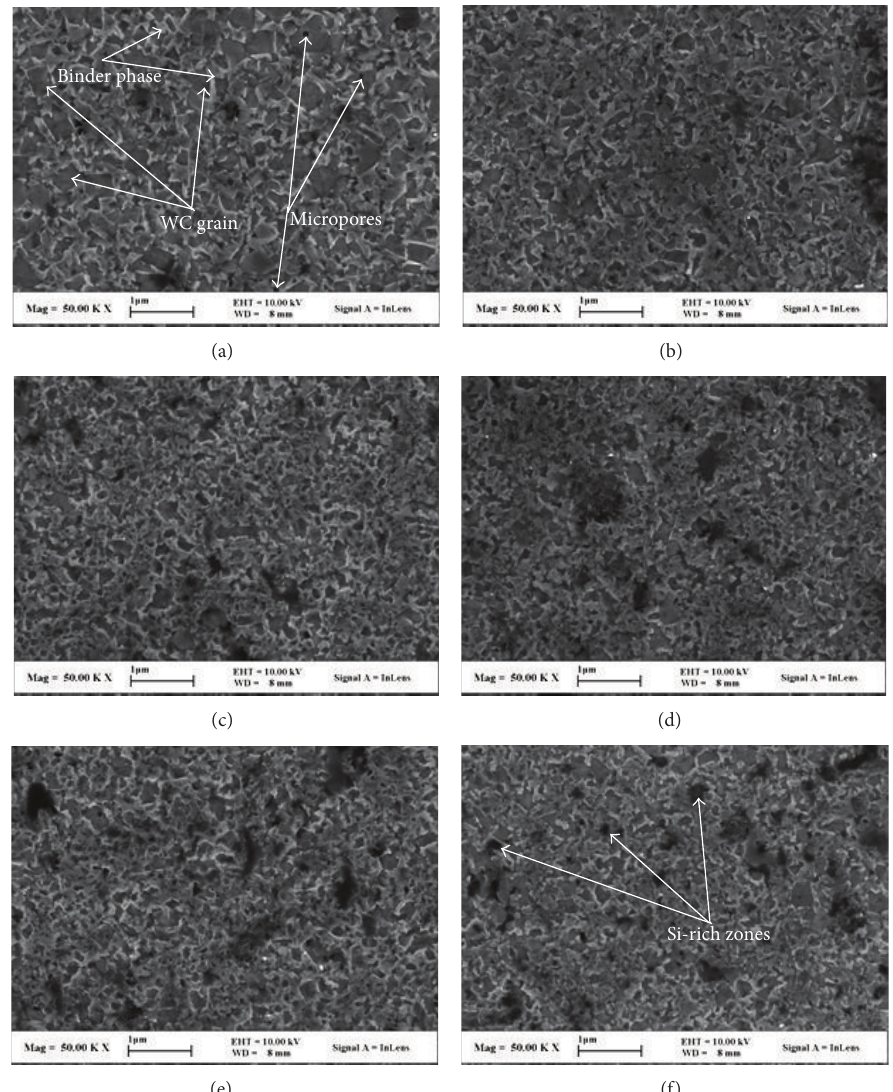
Figure 4: Typical SEM micrographs on the etched surfaces of the prepared WC-Ni cemented carbides with varied fractions of SiC nanowhisker: (a) 0wt.%, (b) 0.75 wt.%, (c) 1.5 wt.%, (d) 2.25 wt.%, (e) 3.0 wt.%, and (f) 3.75 wt.% (etched by Murakami’s reagent for 2min).